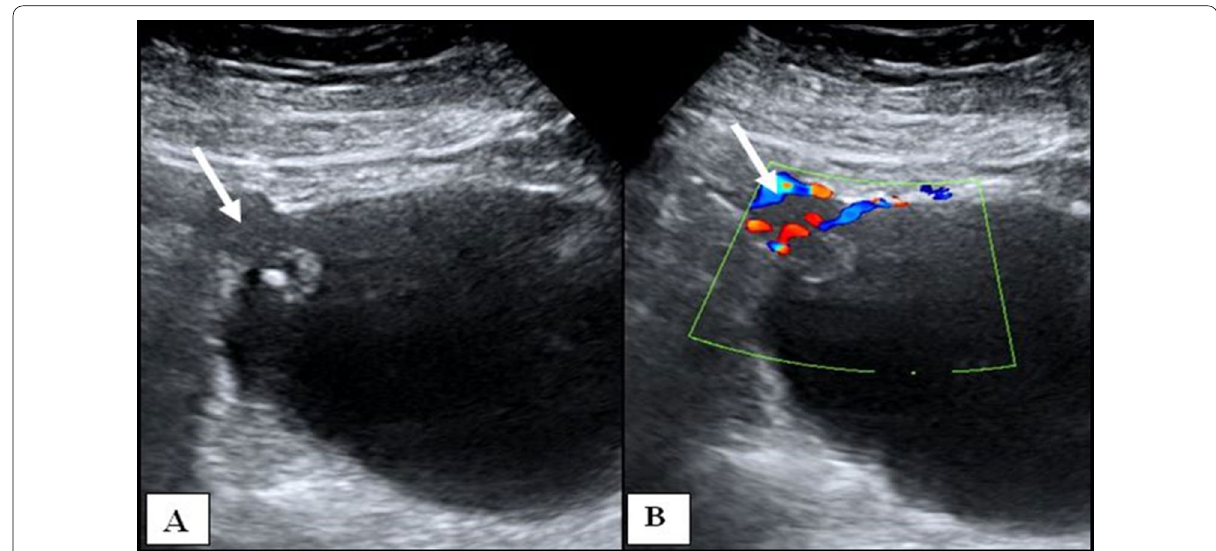
Fig. 1 A Grayscale ultrasound image of the urinary bladder shows a heterogeneously hypoechoic mass in the right lateral wall (arrow). B Color Doppler ultrasound image reveals significant internal vascularity within the lesion